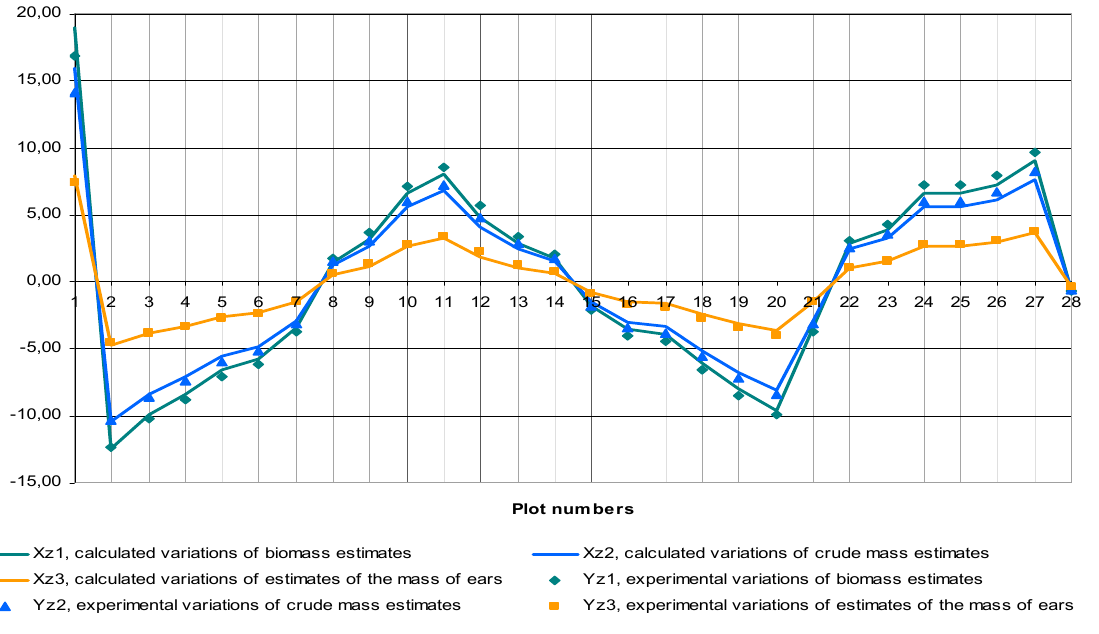
Figure 7. Adjustment of the spatial corrector of estimates of the biomass of spring wheat sowing in the time interval from heading to grain ripening.